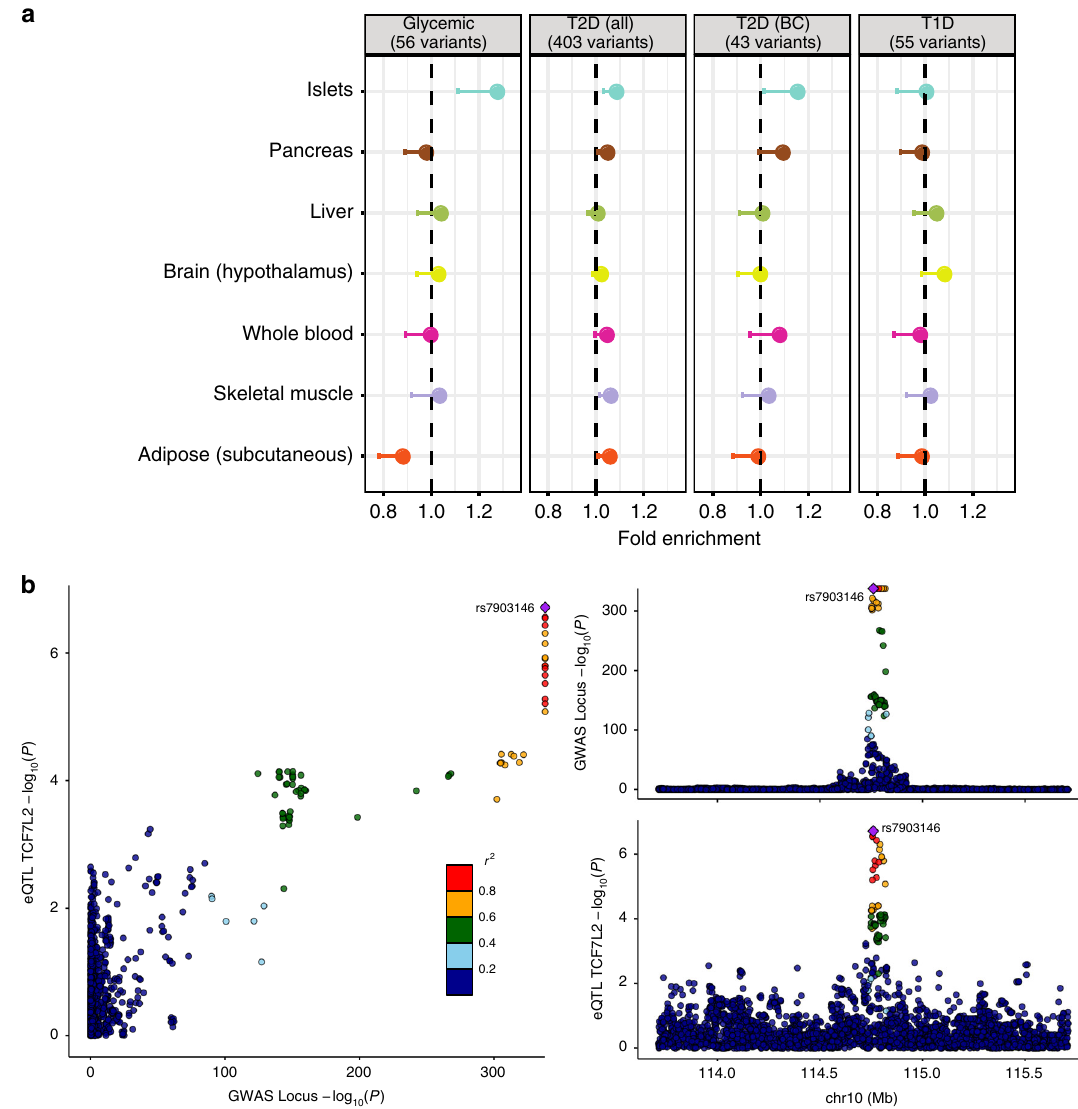
Fig. 3 GWAS SNPs in islet eQTLs. a Enrichment of eQTL effect sizes in different GTEx tissues at T2D (all) and glycemic GWAS-associated variants. Numbers within square brackets denote the number of variants implicated for each the trait. Also shown a subset of T2D GWAS associated with reduced insulin secretion or islet β -cell dysfunction (T2D (BC)) and type 1 diabetes (T1D)-associated signals. b LocusCompare plot for the T2D GWAS p -values in the TCF7L2 locus. Plots on the right − log10 p -values for the GWAS (top) and for the the eQTL for TCF7L2 , highlighting in both the GWAS lead SNP in the cis window tested for eQTLs. On the left it shows a comparison of the p -values in both analyses. Source data are provided as a Source data fi